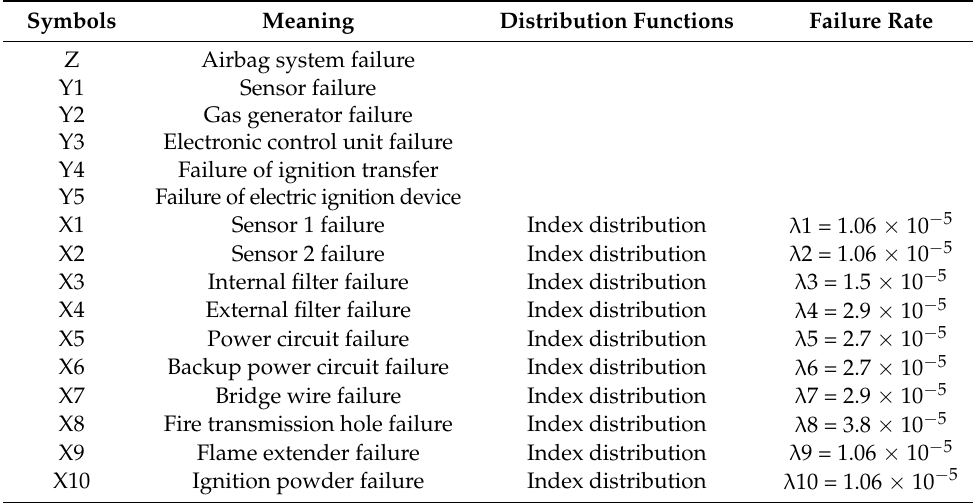
Table 1. Table of symbol meanings and their failure distribution in dynamic fault trees.